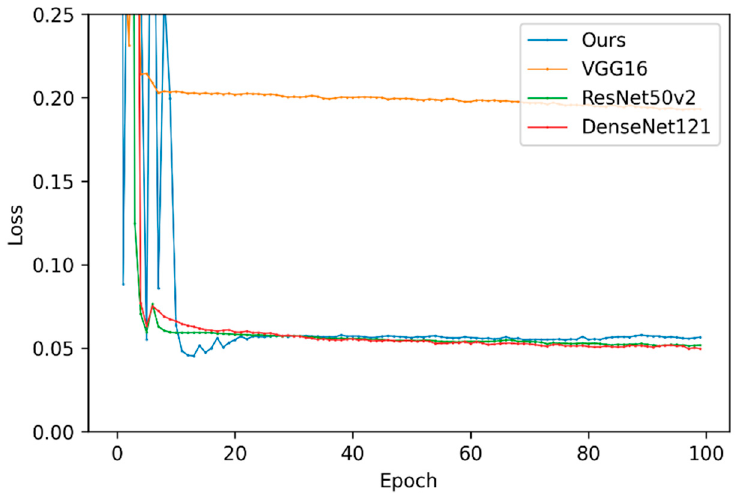
Figure 10. Validation loss of all single CNN models.